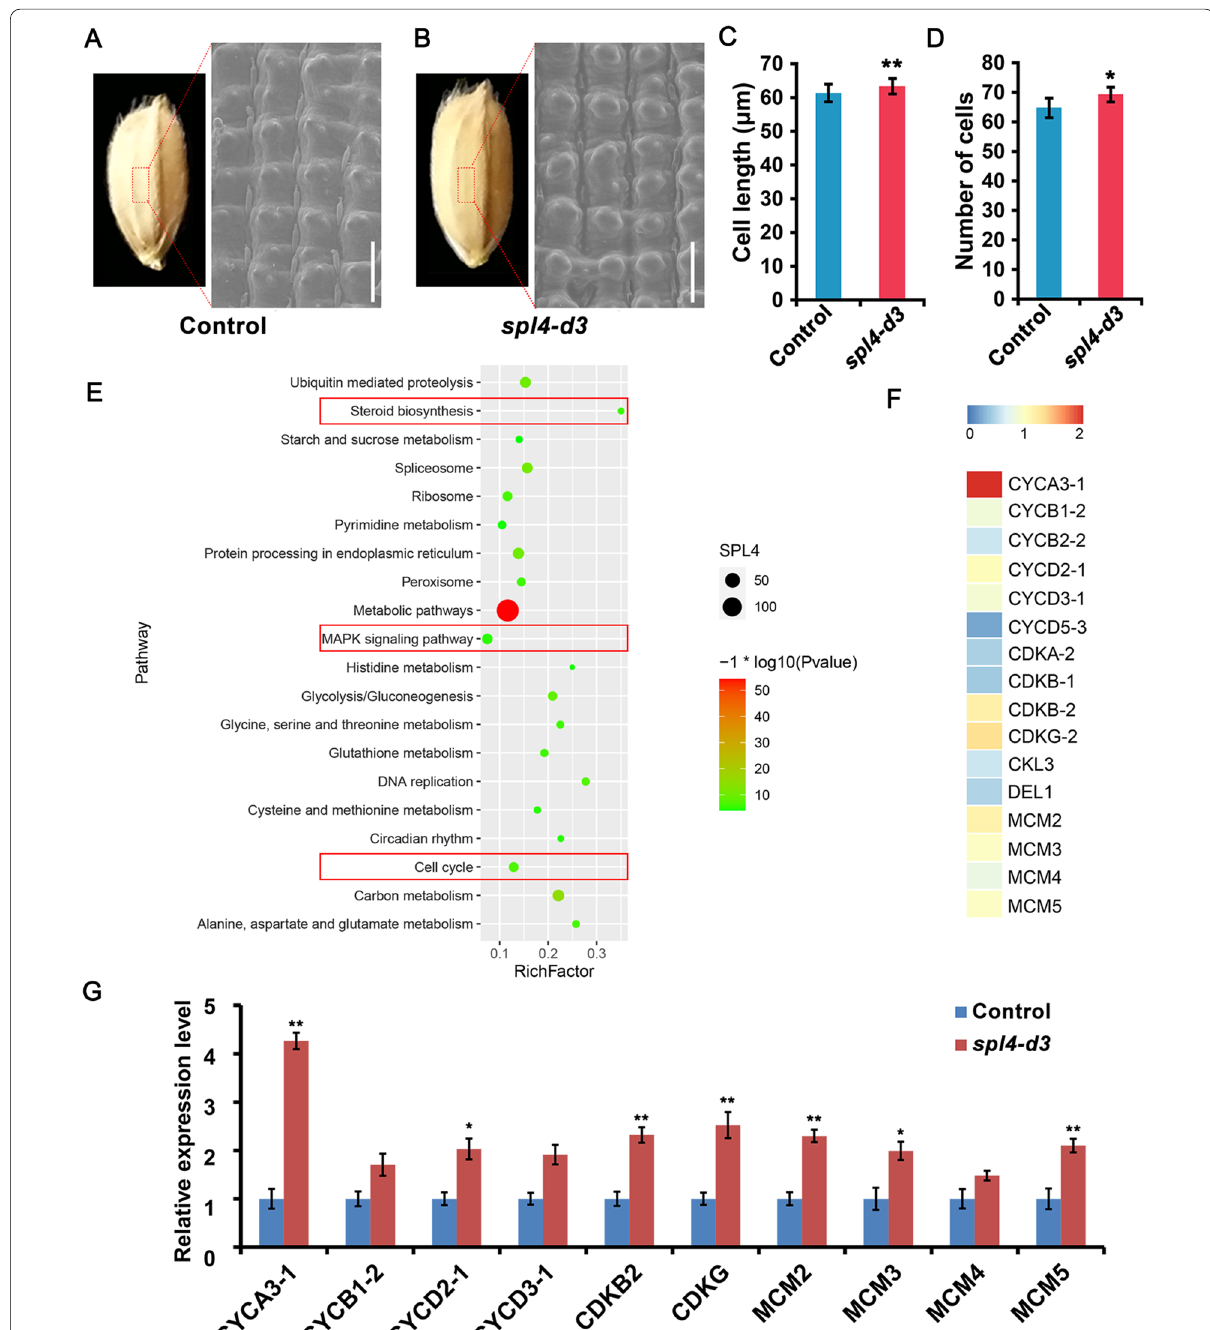
Fig. 4 OsSPL4 regulates spikelet hull development by affecting cell proliferation A , B Scanning electron microscope images of the outer glume (middle), A Control plants; B spl4-d3 lines, scale bar 100 μm. C , D Comparisons of cell length and cell number in the longitudinal direction of the = spikelet between the control and spl4-d3 plants (n 10 spikelets). C Cell length. D Cell number. E KEGG pathway of the DEGs identified in young = panicles of the control and spl4-d3 transgenic plants. RichFactor is the ratio of DEG number and background gene number. F Heatmap showing the expression levels of genes related to floral organ identify in our RNA-seq between the spl4-d3 lines and control plants. Fold change of the FPKM values ( spl4-d3 /control) were used. G Comparisons of the expression levels of cell-cycle genes in young panicles of the control and spl4-d3 plants using qRT-PCR. The data are presented as mean SD (n 3). Significant difference was determined by Student’s t test, * P < 0.05, ** P < ± =